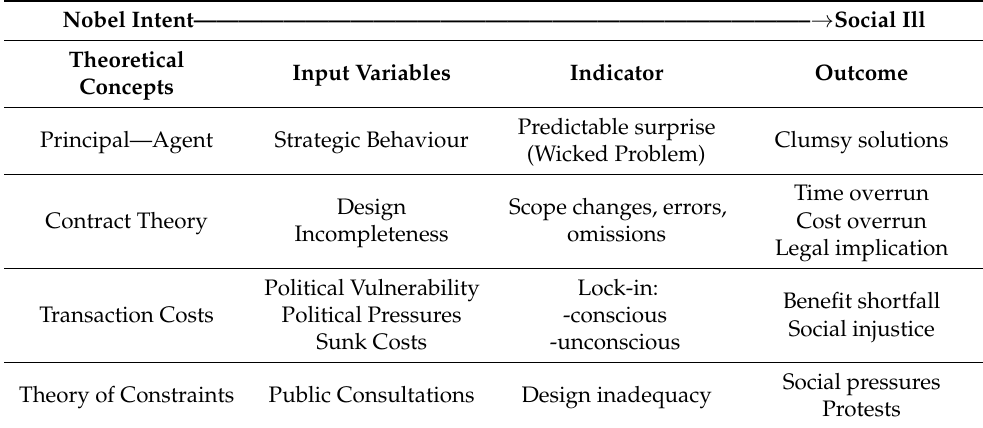
Table 1. The theoretical framework for politically vulnerable